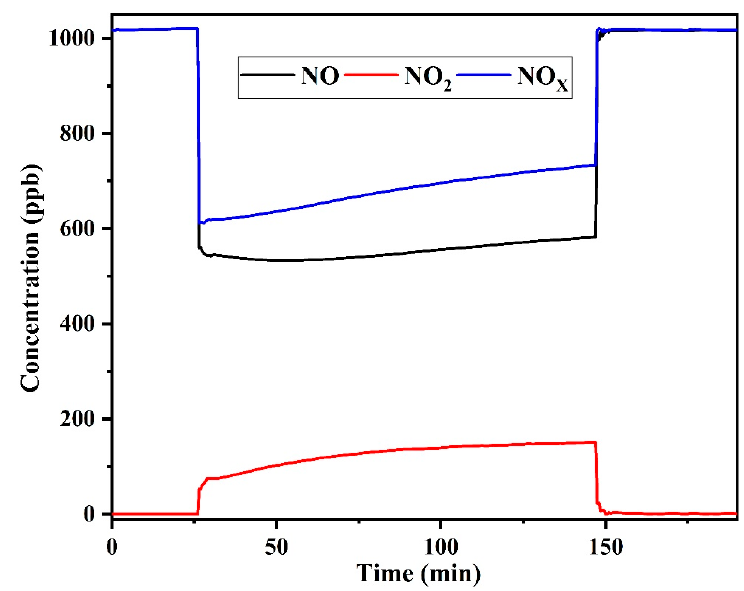
Figure 5. Concentration outlines of NO, NO 2 and NOx for TiO 2 /quartz sand during the photocatalytic oxidation of NO.